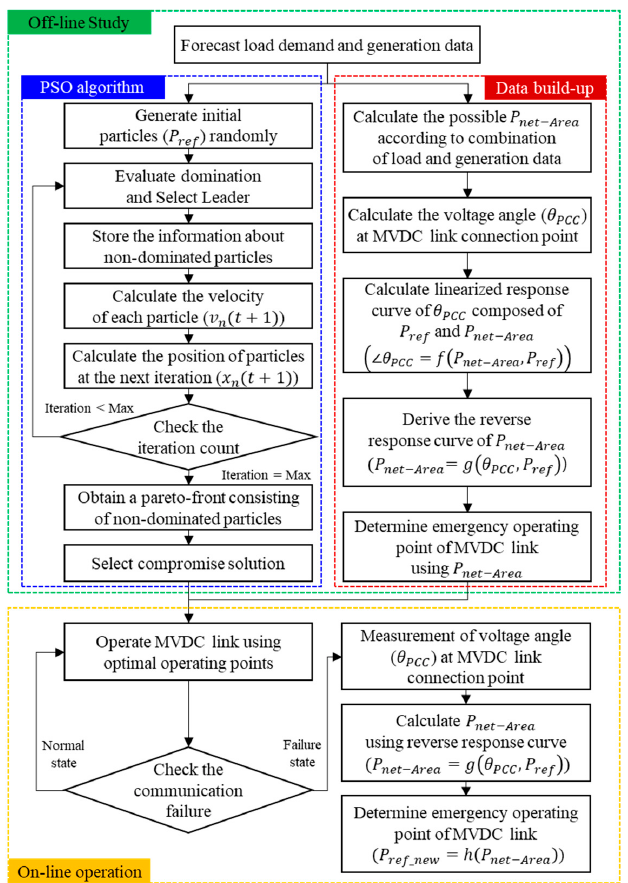
Figure 2. Flowchart for operating the MVDC link.